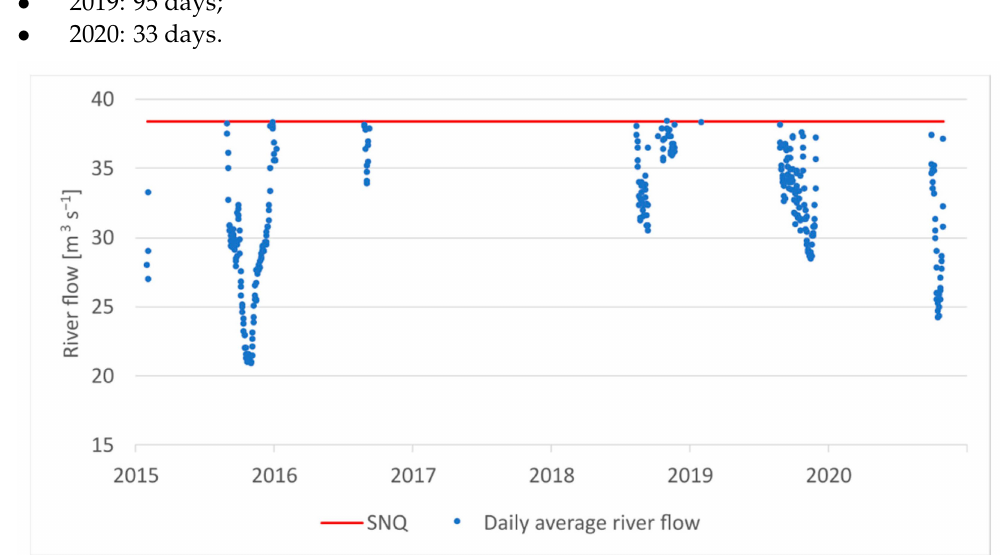
Figure 10. Flow rates lower than or equal to the SNQ